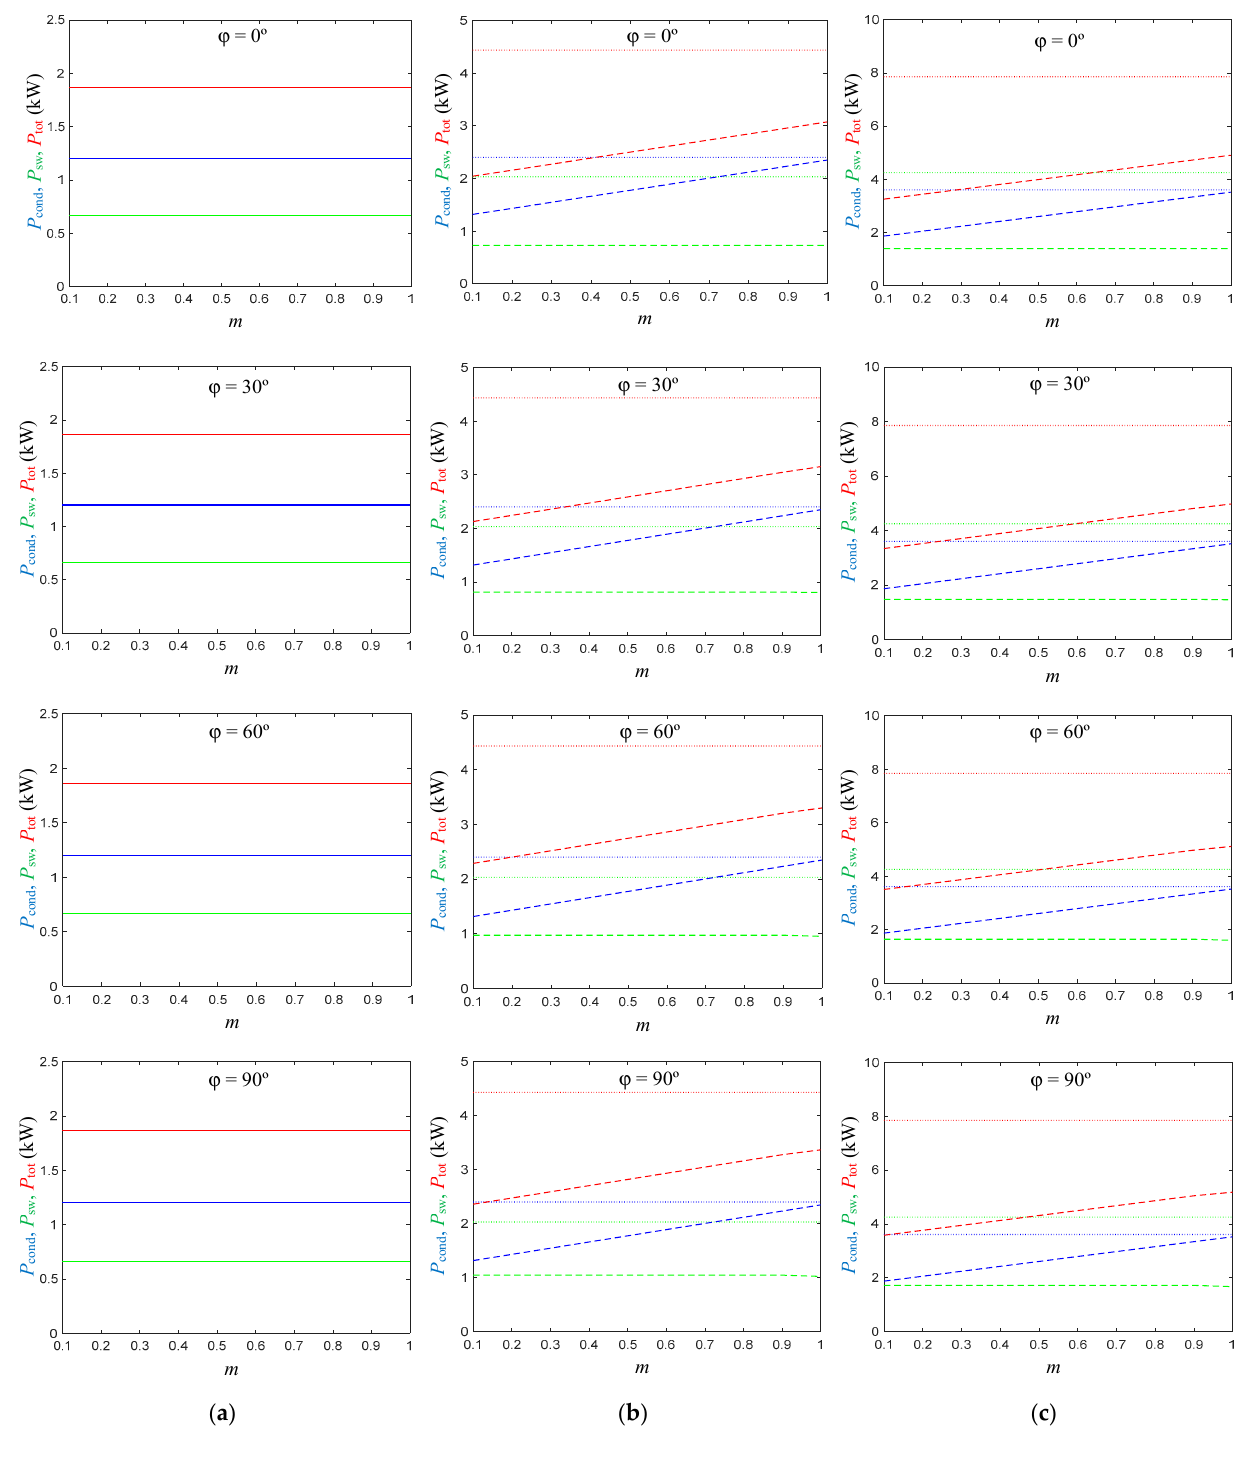
Figure 4. Average conduction P cond (blue), switching P sw (green), and total P tot (red) inverter power loss at the nominal phase current ( I ph,nom ) and several motor phase current-voltage displacement angles φ , as a function of the modulation index. Dotted lines correspond to design A, dashed lines correspond to design B, and solid lines correspond to both design A and design B. ( a ) EV 1 . ( b ) EV 2 . ( c ) EV 3 .